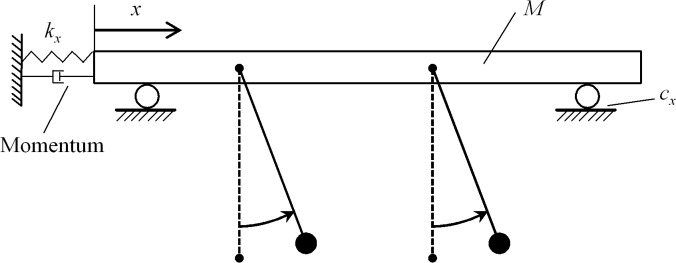
A schematic illustration of the simplified model.